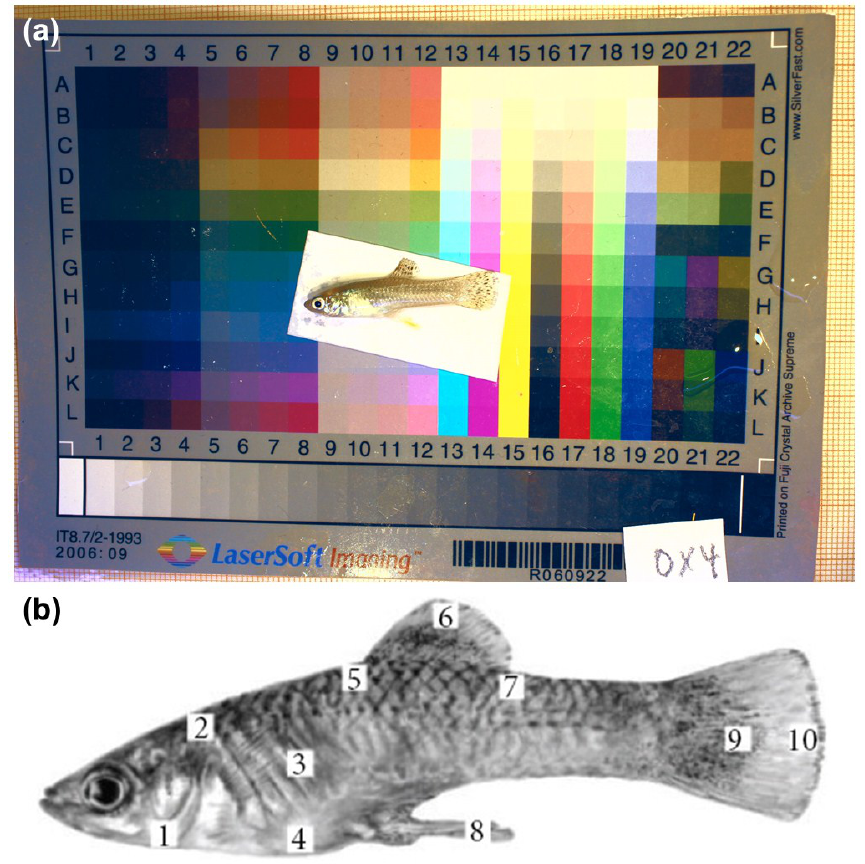
Figure A1. ( a ) Example of a male from a non-sulfidic habitat in the Tacotalpa drainage photographed on the calibration plate; ( b ) illustration of the 10 regions on the body at which color ( L * a * b *) measurements were